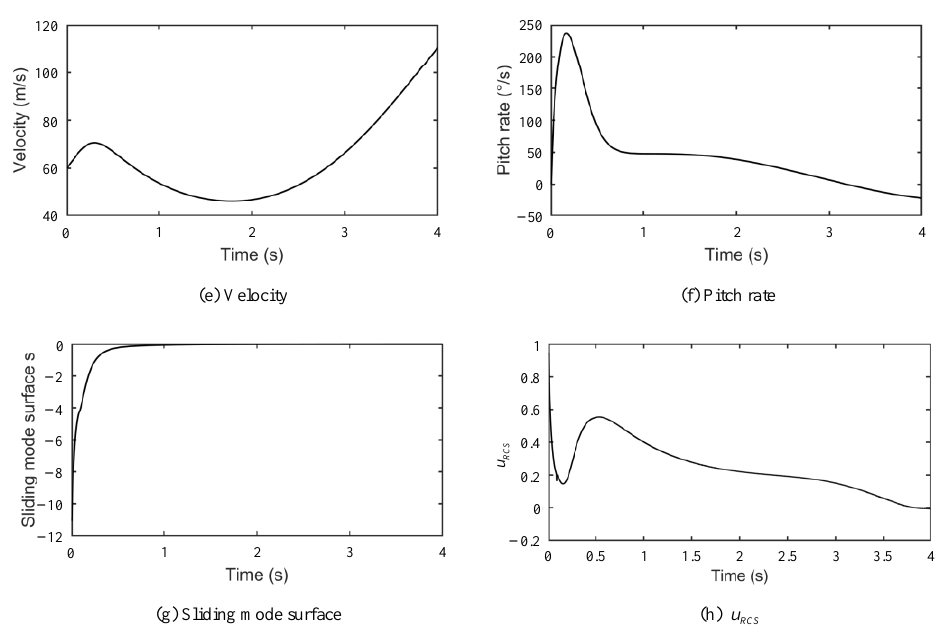
Figure 2. Responses for a command tracking scenario.